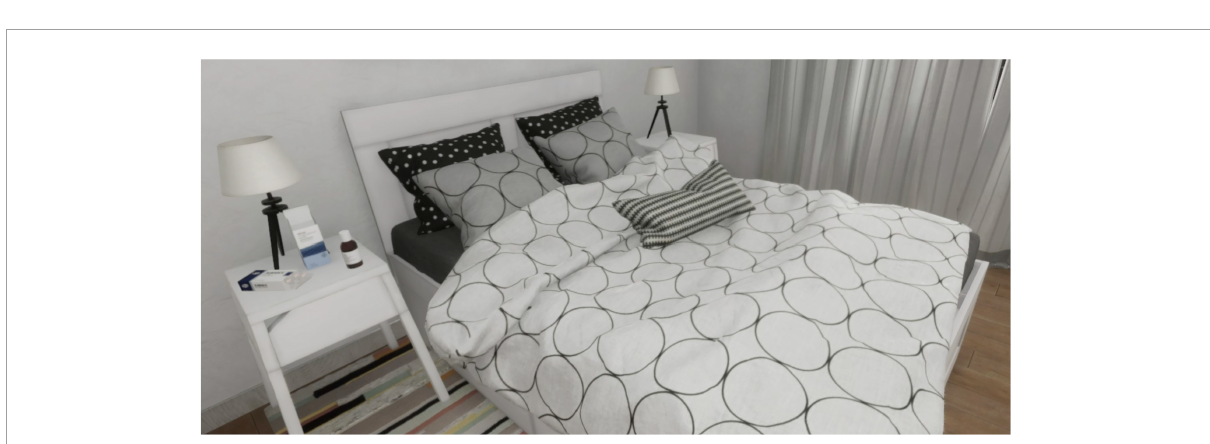
FIGURE5 Scenario with